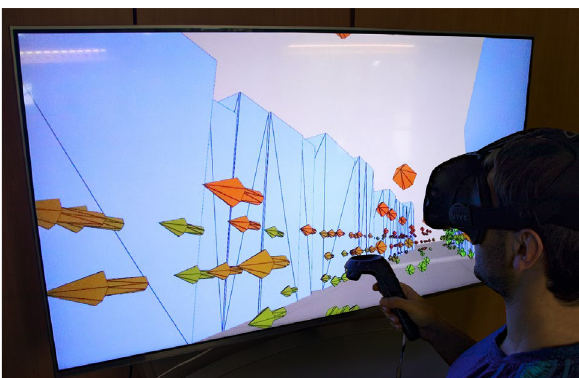
Figure 9. Wind velocity depicted in